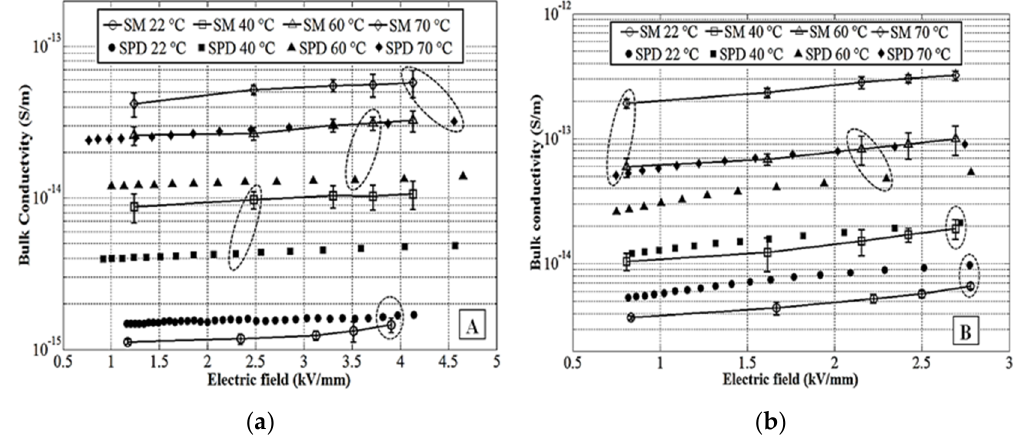
Figure 5. Field dependencies of the bulk conductivities of materials A ( a ) and B ( b ) at different temperatures obtained from the SPD characteristics and standard measurements (SM in the legends).